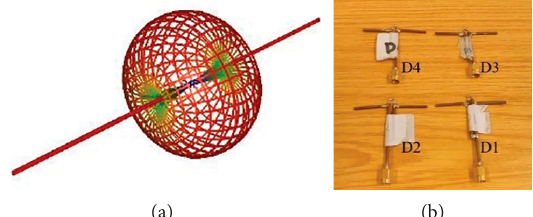
Figure 12: (a) Simulation design of a dipole antenna and (b) the fabrication of dipole antennas